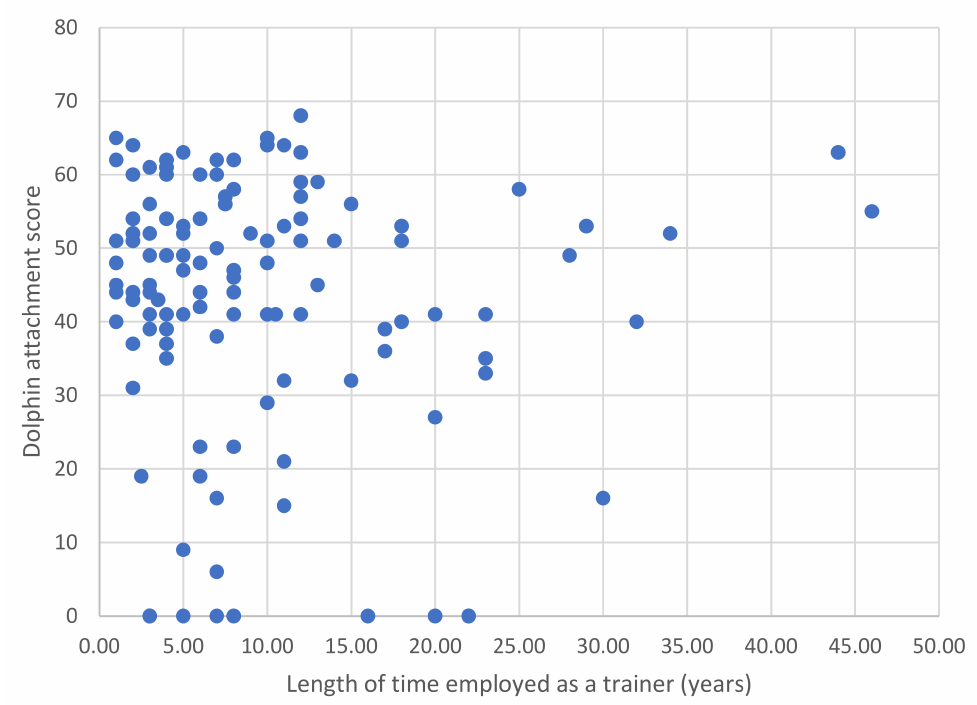
Figure 3. Relationship between length of time employed as a trainer and LAPS dolphin attachment score ( n =